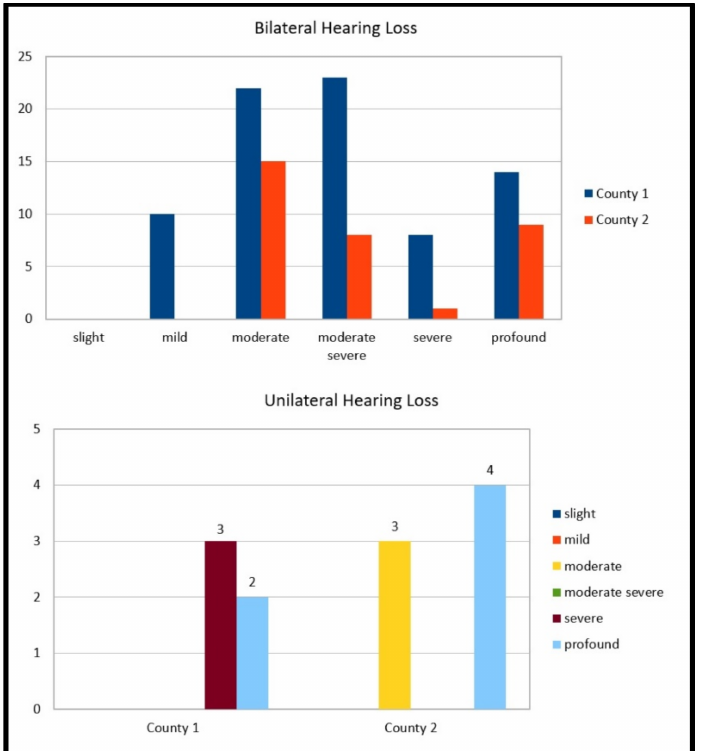
Figure 2. Bilateral and unilateral cases of hearing loss identified in the studied cohorts, according to WHO classification. In very few cases (globally 3) of asymmetrical hearing loss, mainly syndromic pictures, better ear and worse ear did not differ significantly in terms of the hearing threshold. Better ear is intended to indicate the degree of hearing loss.